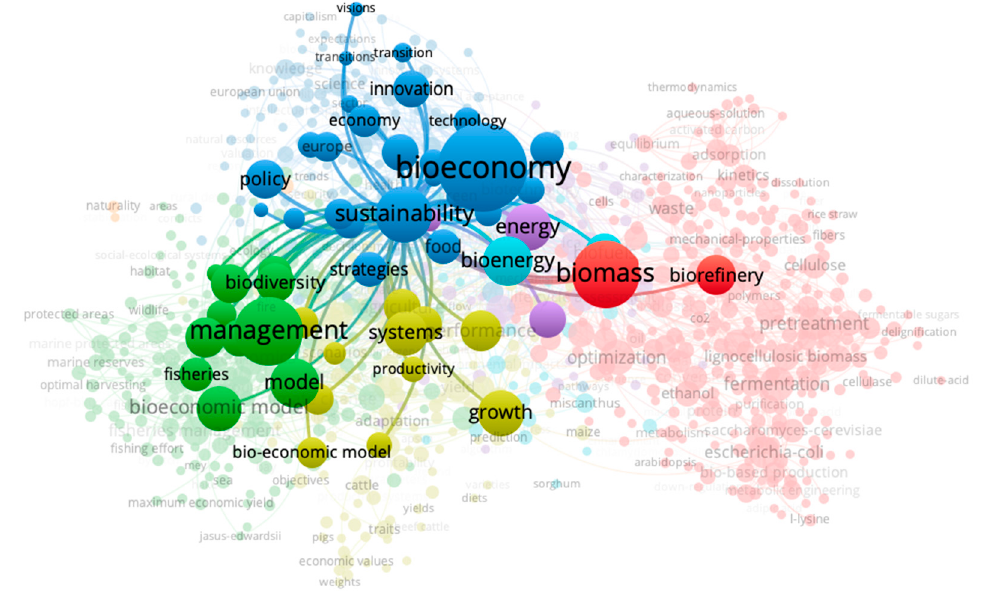
Figure 10. Key-word co-occurrence map (VOSviewer software).